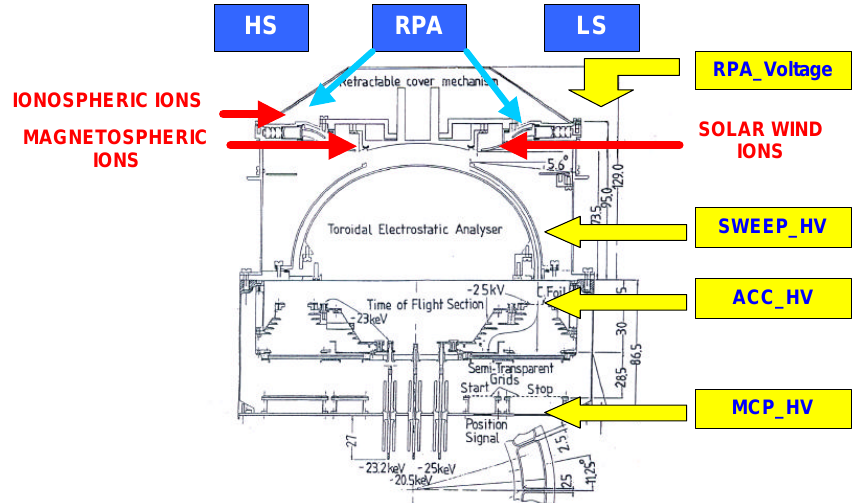
Fig. 9. Cross sectional view of the CODIF sensor. The voltages in the TOF section are shown for a 25kV post-acceleration.